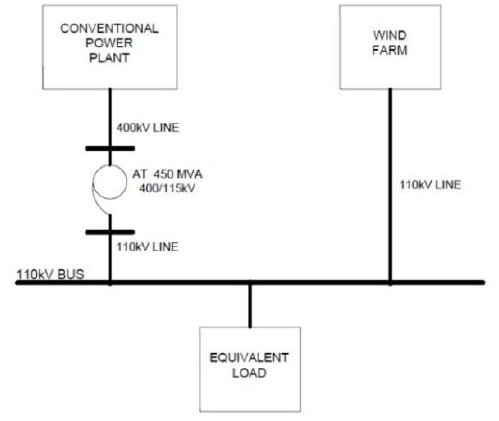
Figure 1. A scheme of the considered system.